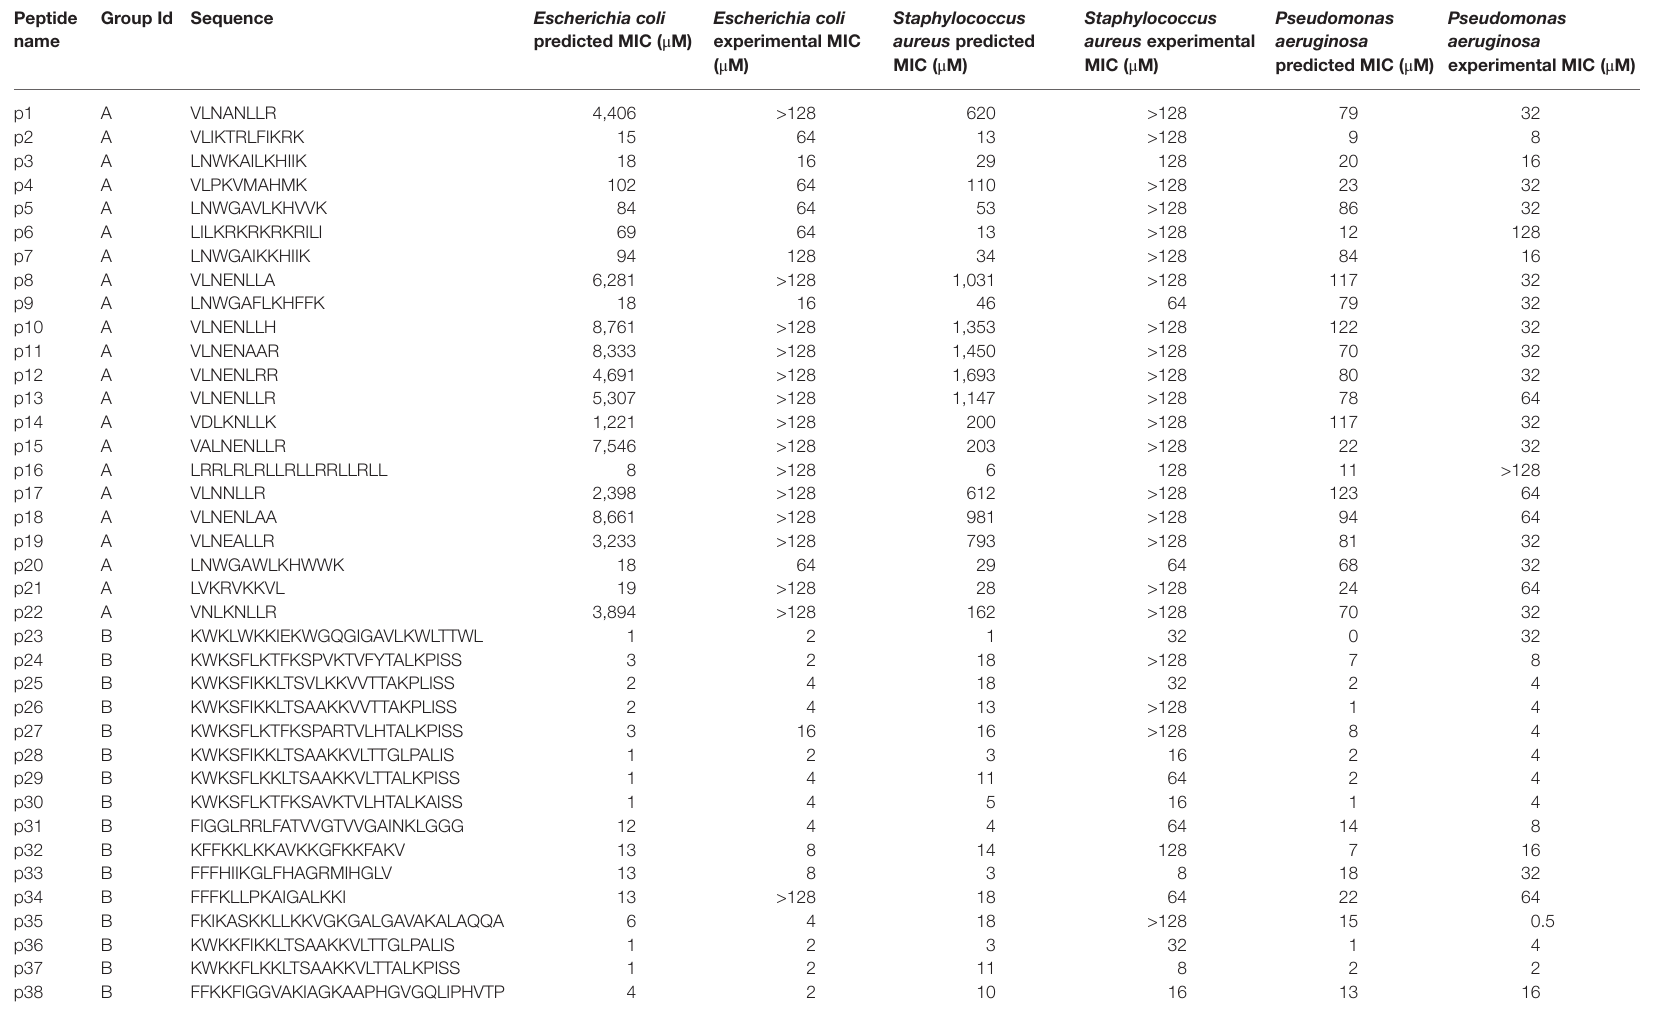
TABLE 2 | Minimum inhibitory concentration (MIC) assay